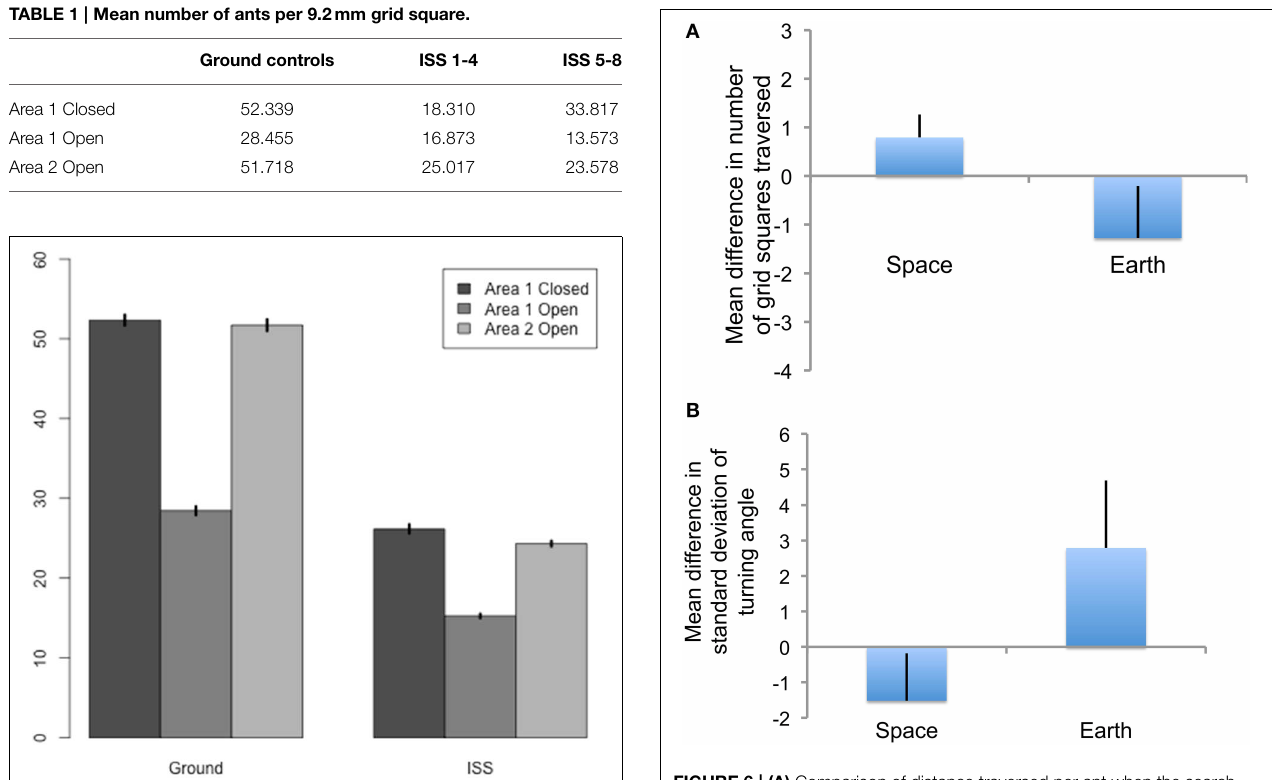
FIGURE 6 | (A) Comparison of distance traversed per ant when the search area expanded. Shown are the means over all replicates of the mean numbers of large grid squares (9.2mm by 9.2mm) traversed in Area 1 before the barrier was opened minus the mean numbers of grid squares traversed in Area 2 after the barrier was opened. Error bars show standard errors of the mean. (B) Comparison of path shape when the search area expanded. Shown are the means over all replicates of the mean standard deviation of turning angle in Area 1 before the barrier was opened minus the mean standard deviation in turning angle in Area 2 after the barrier was opened. Error bars show standard errors of the mean.